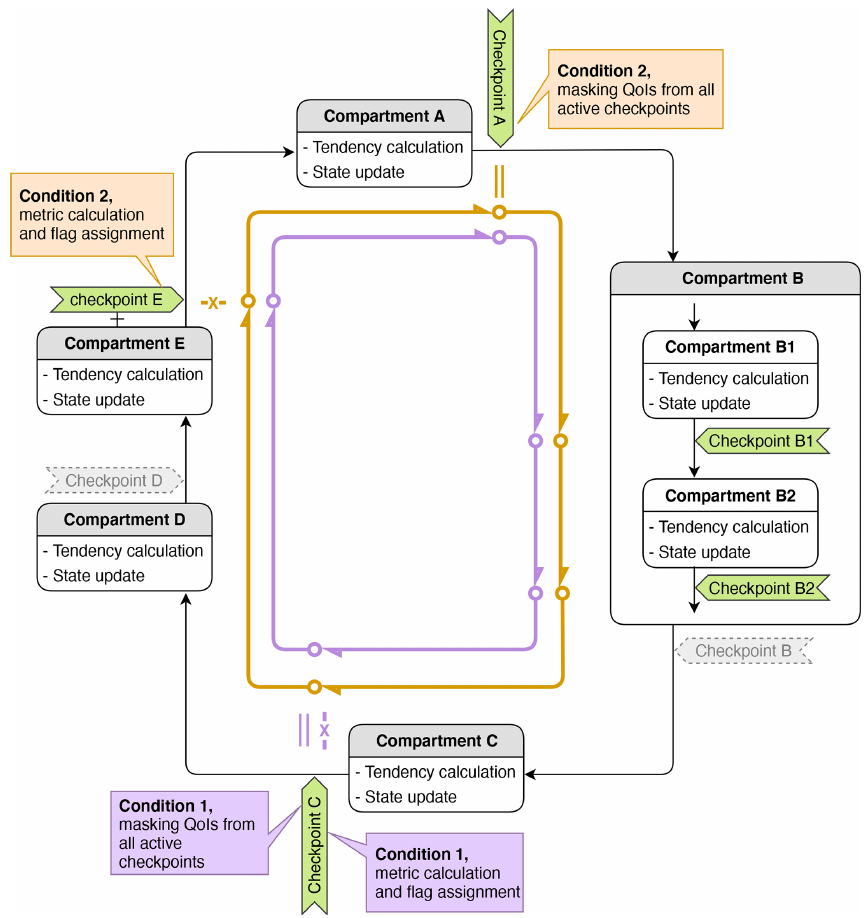
Figure 3. A schematic showing two sampling conditions indicated in brown and purple. The “X” marks indicate locations in the time inte- gration cycle at which the condition metrics are evaluated. The double bars indicate the end of validity of the evaluated sampling conditions. More details can be found in Sect. 3.2.4. Like in Fig. 2, green tags are active checkpoints being monitored by the tool. Gray tags with dashed borderlines are inactive checkpoints, which are ignored in the